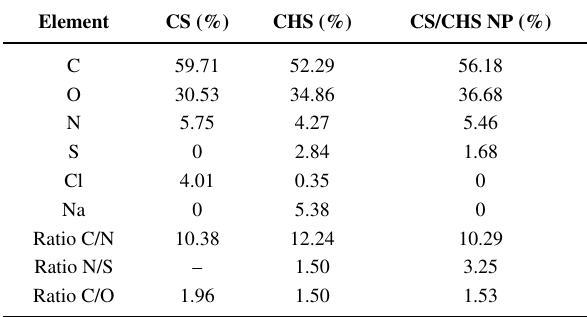
Table 2. Surface elemental composition (atomic %), determined by XPS, of chitosan (CS), chondroitin sulfate (CHS), and chitosan/chondroitin sulfate nanoparticles (CS/CHS